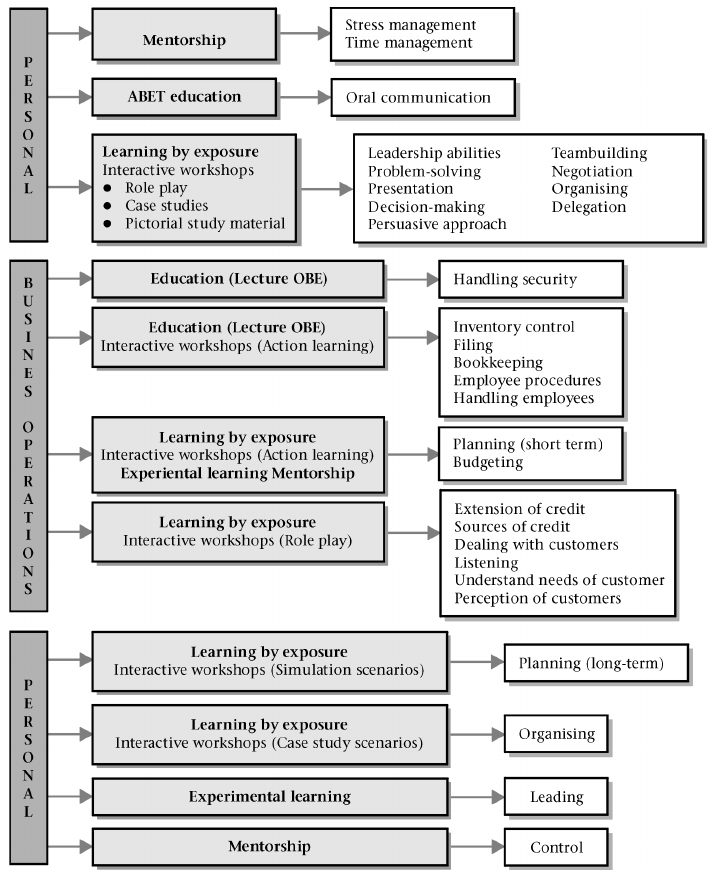
Figure 2:A model of suggested training interventions/methods for upgrading black micro entrepreneurial